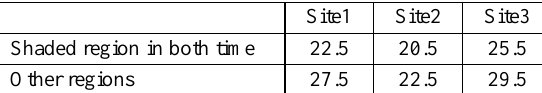
Fig.6. Histograms for texture changed value Table 4. Thresholds for texture changed